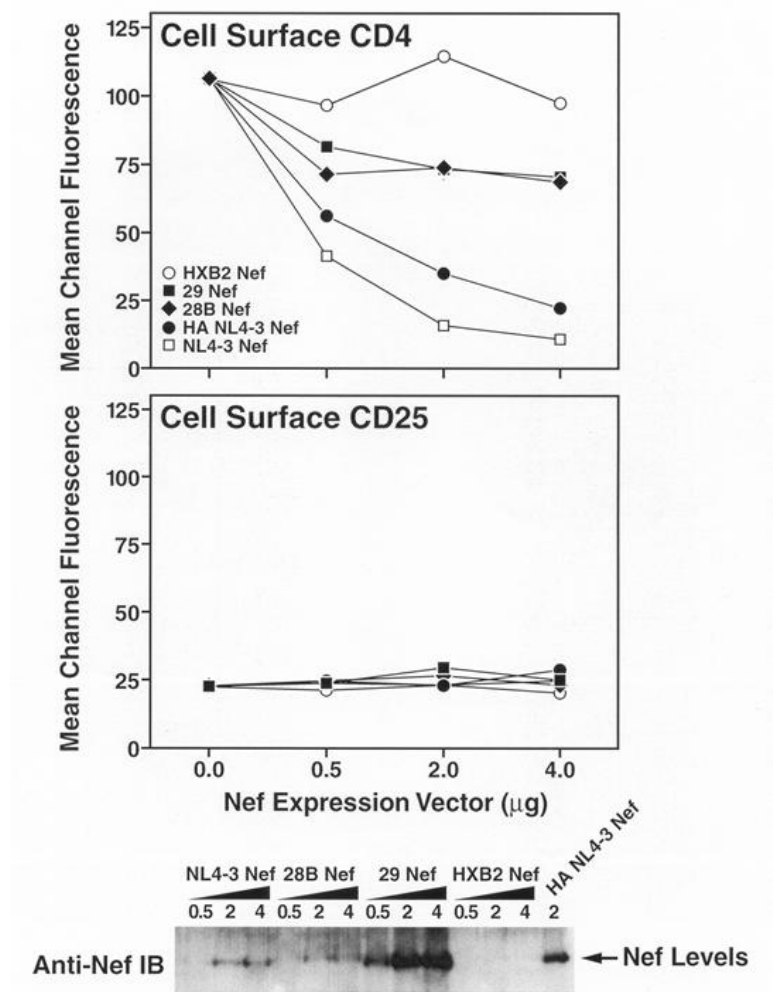
Figure 3. CD4 down-regulation by patient Nefs. Patient nef clones were transfected with CD4 and CD25 plasmids. Top: expression of cell surface CD4. Center: expression of cell surface CD25. HIV- Nef, open squares; HIV-1 Nef-HA, filled circles; HIV-1 Nef, open circles; HIV-1 1 NL4-3 NL4-3 HXB2 Nef (child), diamonds; HIV-1 (mother), filled squares. Bottom: Western blot analysis of Nef M29 C28B expression of Nef in transient transfections shown at